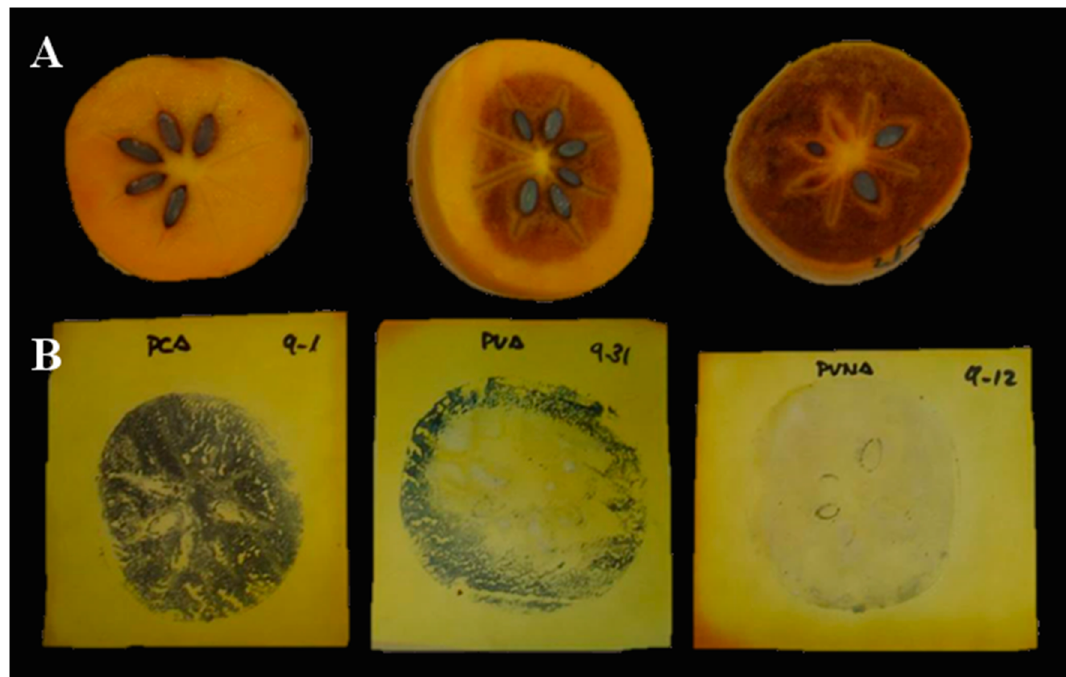
Figure 3. Three types of astringent persimmon according to the amount of acetaldehyde produced by the seed; ( A ) fruits of pollination constant astringent (PCA), PVA and pollination variant non-astringent (PVNA; from right to left) and ( B ) distribution of condensed tannins, visualized by precipitation of blue ferric chloride impregnated in a paper [25,26]. Fruits of PCA, PVA and PVNA (from right to left).